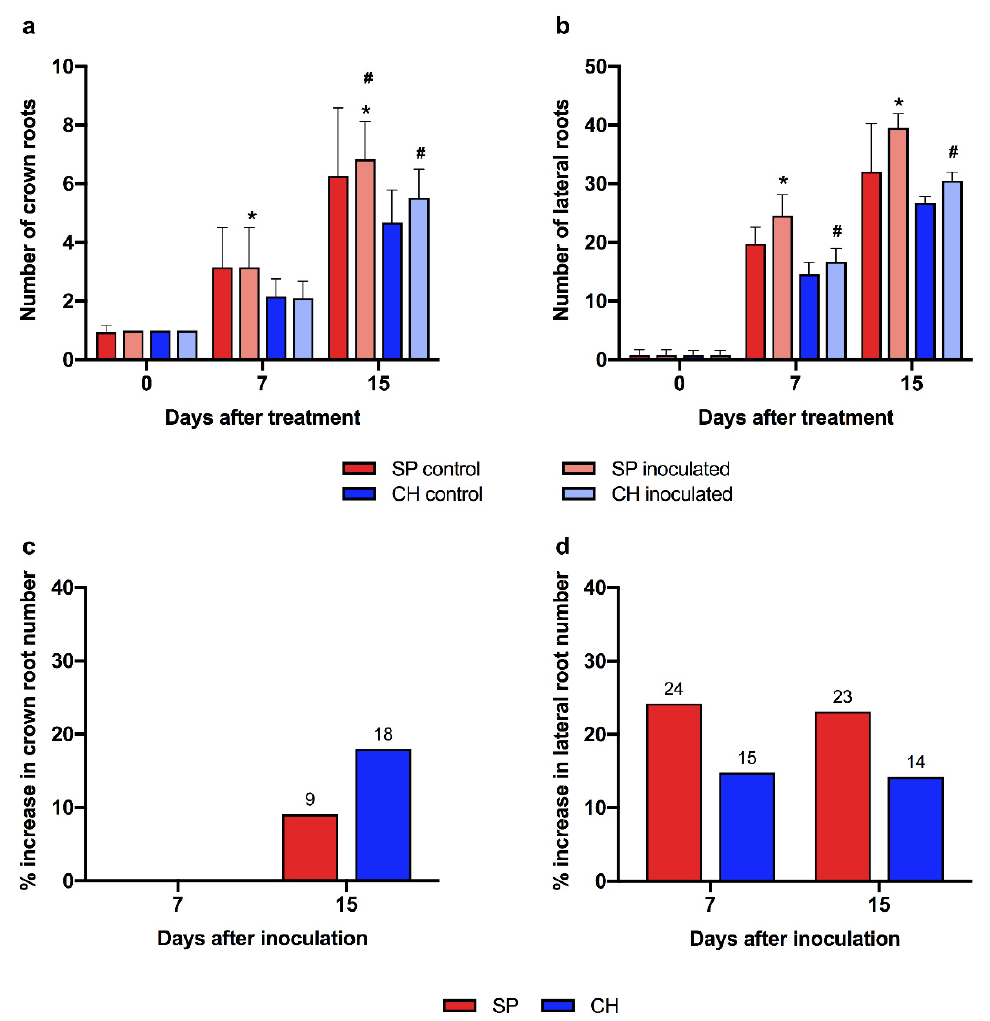
Figure 10. Analysis of root growth in the contrasting genotypes treated with 2 mM NAA in hydroponics. Evaluation of ( a ) crown and ( b ) lateral roots, and % of increase in ( c ) crown and ( d ) lateral root number in plants treated with 2 mM NAA. Analyses were performed 0, 7 and 15 days after treatment. The symbol (*) indicates significant differences between SP and CH control plants at the same time point. The symbol (#) indicates significant differences between control and NAA treated plants of the same genotype at the same time point. Bars indicate mean ± standard error of three independent experiments.